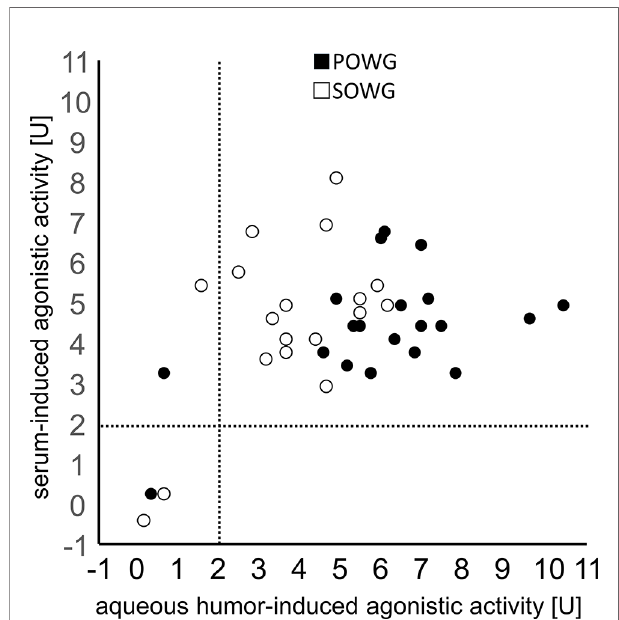
FIGURE 2 | Correlation of the agonistic activities of b 2-agonistic autoantibodies in sera and aqueous humor. AH samples and corresponding seraof patients with POAG ( fi lled dots) or SOAG (open dots) are displayed. Note, the activity values are mutually independent (p > 0.05, Spearman